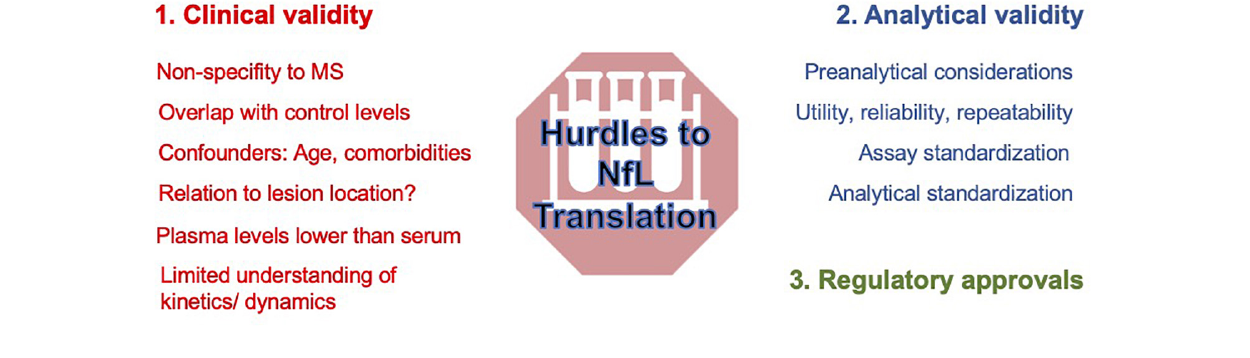
FIGURE 1 | Barriers to the clinical translation of sNfL in